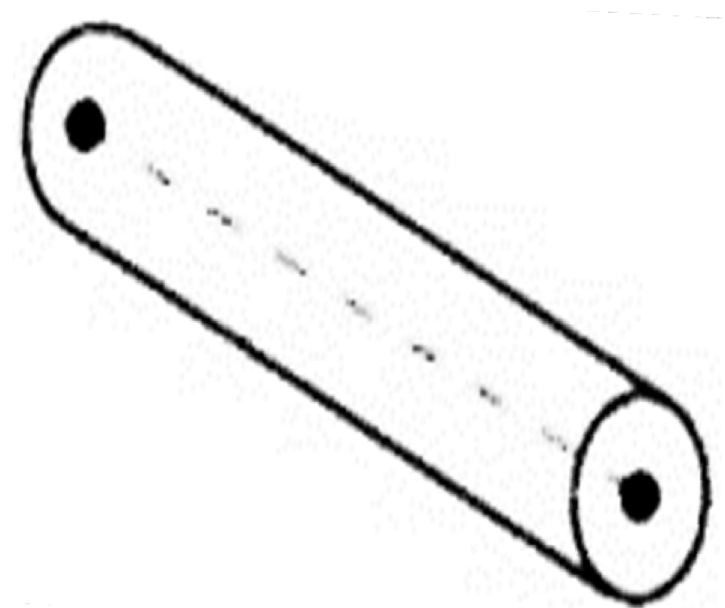
Fig. 10 Two-node linear three-dimensional truss element (T3D2)